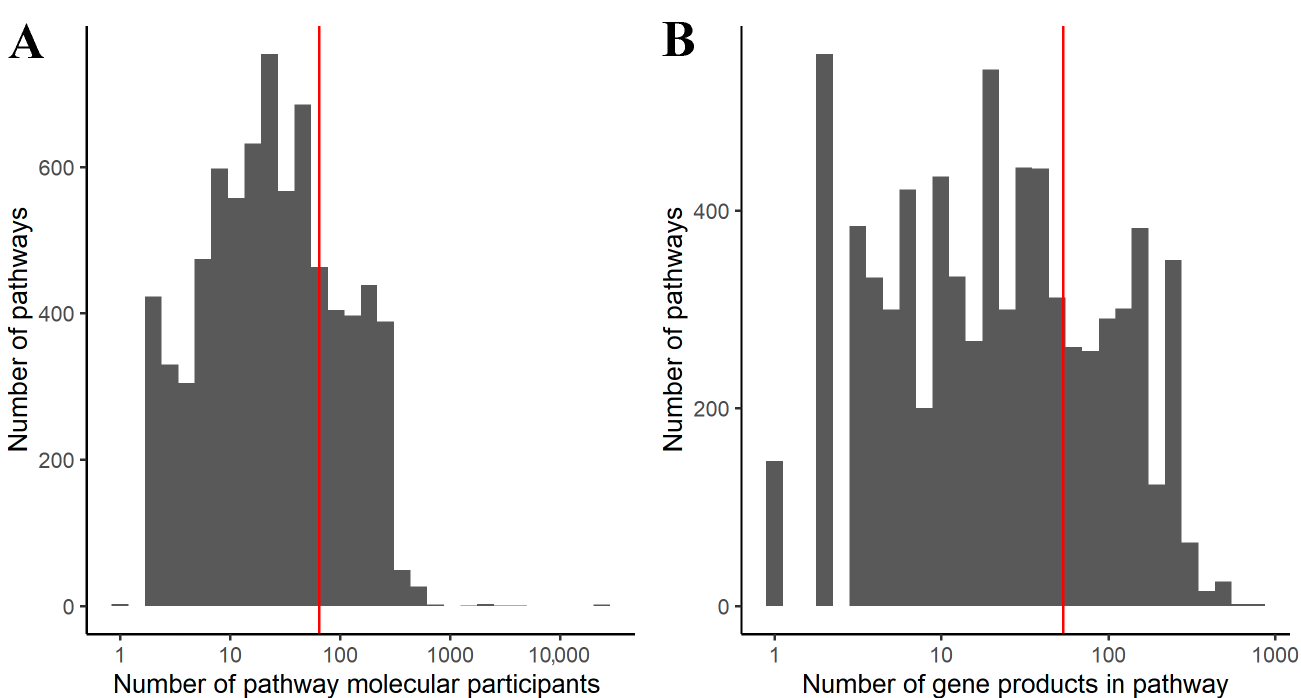
Figure 2. Size distribution of gene-centric molecular pathways ( A ) when all molecular interactors are considered; ( B ) when only gene products are considered. Vertical red line shows mean a value.